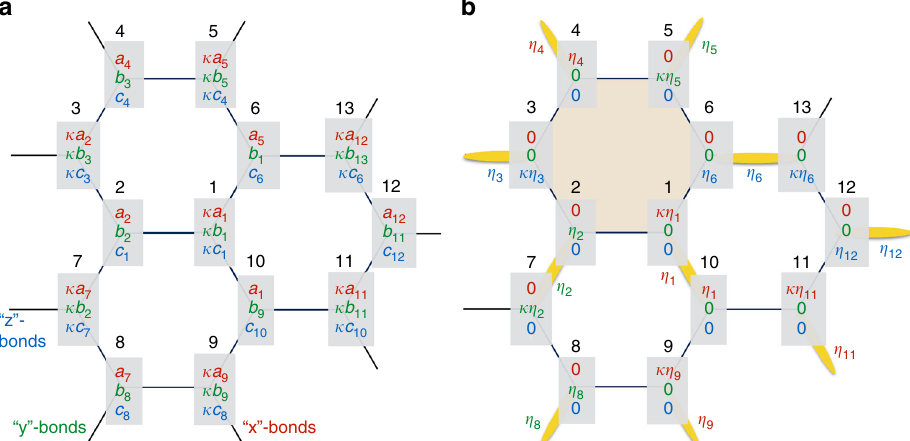
Fig. 1 Classical ground states of the Kitaev model on the honeycomb lattice. The lattice has three types of NN bonds, labeled by “ x ” , “ y ” , and “ z ” . a General form of ground states. The numbers 1 – 13 label the spin sites, and the shaded 3×1 vectors below each number give the corresponding Cartesian components ( x , y , and z ) of the spins (colored red, green, and blue, respectively). Here, κ = − sgn( K ), S i = ( a i , b i , c i ) or κ ( a i , b i , c i ) if i belongs to the A or B sublattice, and a 2 to dimer coverings, with (yellow) dimers representing satis fi ed bonds. The spin orientation of each dimer is described by an Ising-like variable η = ±1 (colored according to the non-vanishing Cartesian component of the two spins shared by the bond). The shaded hexagon has the shortest loop with no